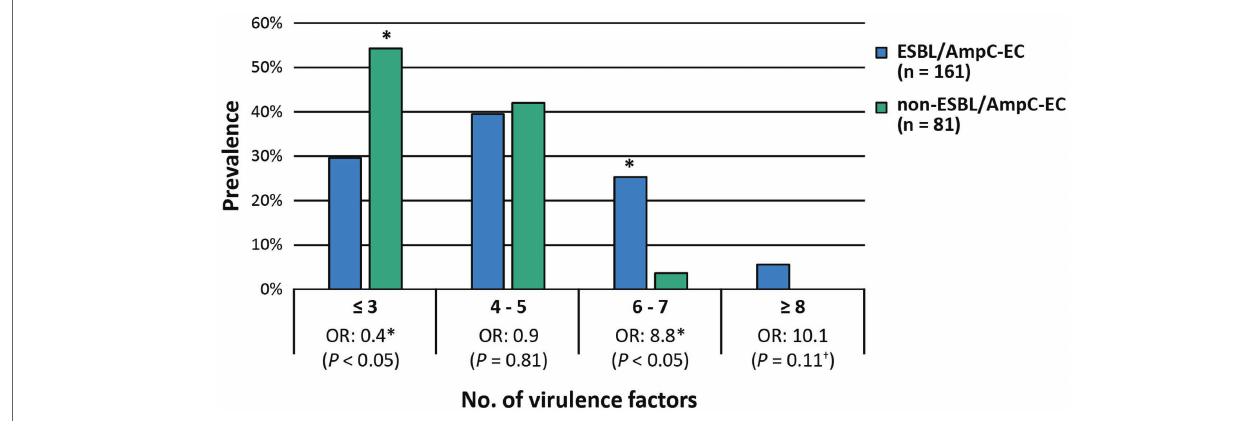
FIGURE 3 | ESBL/AmpC-EC carried higher number of extra-intestinal pathogenic E. coli associated virulence factors (ExPEC VFs) compared to non-ESBL/ AmpC-EC. OR, odds ratio. Statistically significant ( * p < 0.05, GEEs; † p < 0.05, Chi-square test).